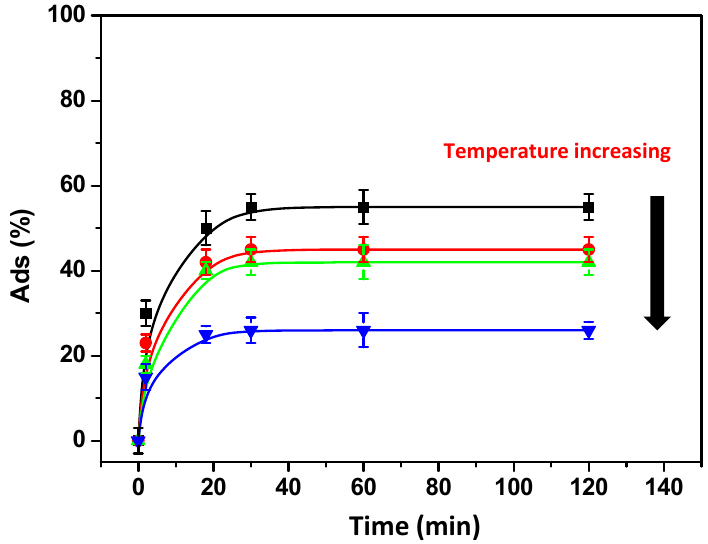
Figure 4. Influence of the temperature at constant CBZ concentration (5 mg/L) and β -EPI polymer dose (6.3 g/L). Black: 293K, Red: 303K, Green: 323K, Blue: 343K.